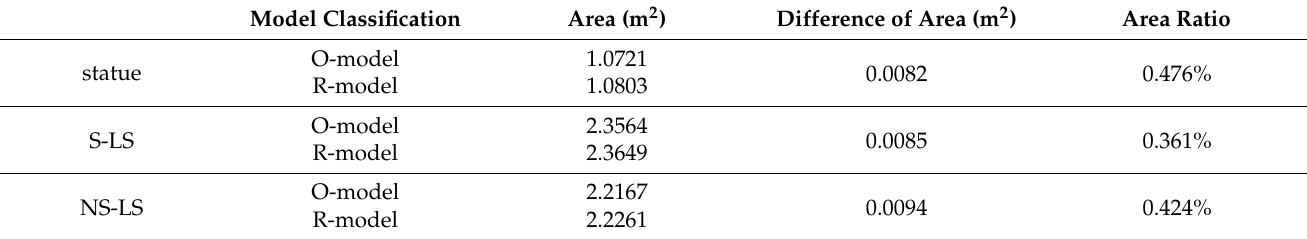
Table 14. The surface area of the model of experimental data.